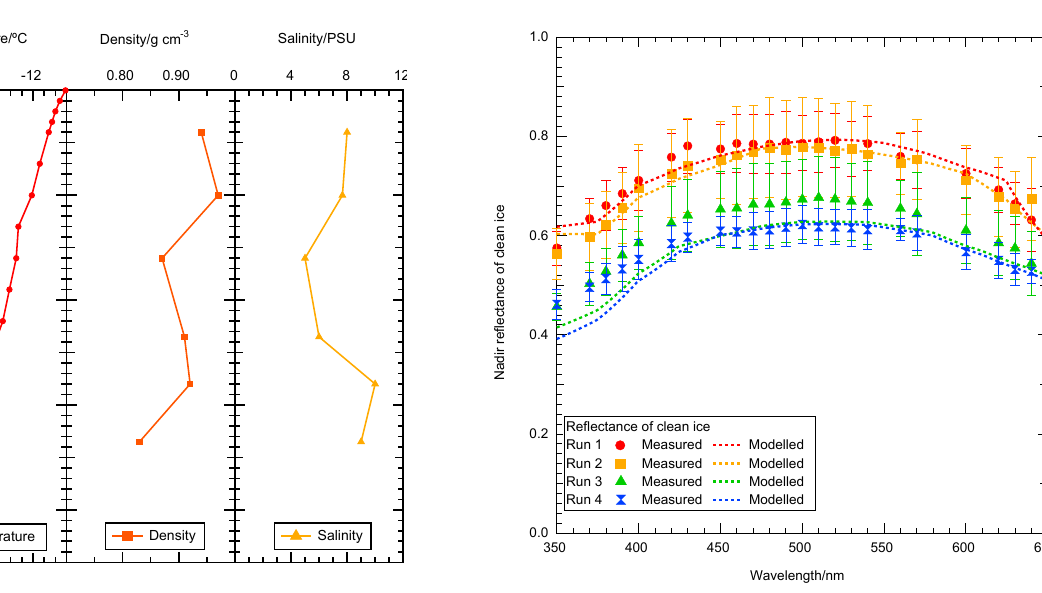
Figure 6. Example temperature, salinity and density data for an ice core from run 2 before the black carbon bearing layer was added. Figure 7. Measured sea ice surface reflectance versus wavelength (solid shapes) and modelled sea ice reflectance versus wavelength (dashed lines) for sea ice with no added black